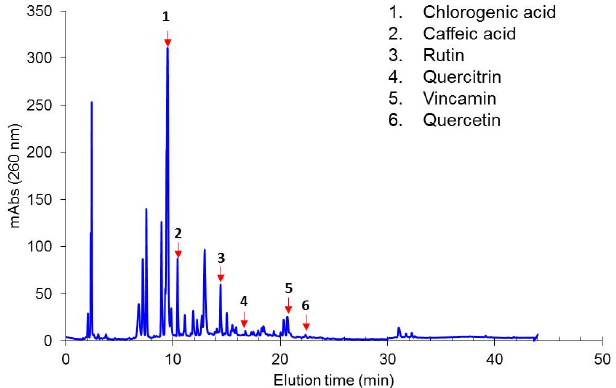
Figure 1. HPLC-DAD chromatogram showing the chemical composition of the V. minor plant extract prepared in this study.